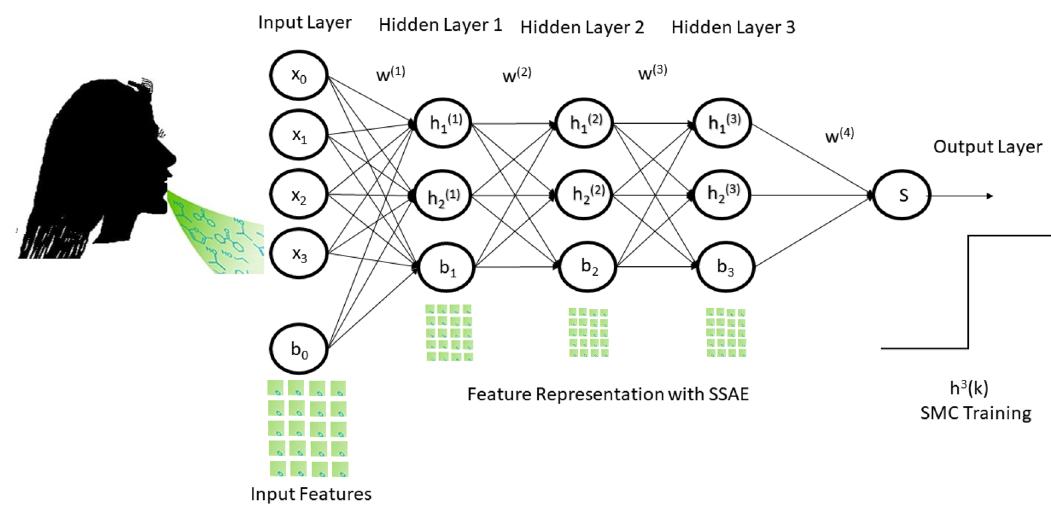
Figure 6. Proposed architecture of